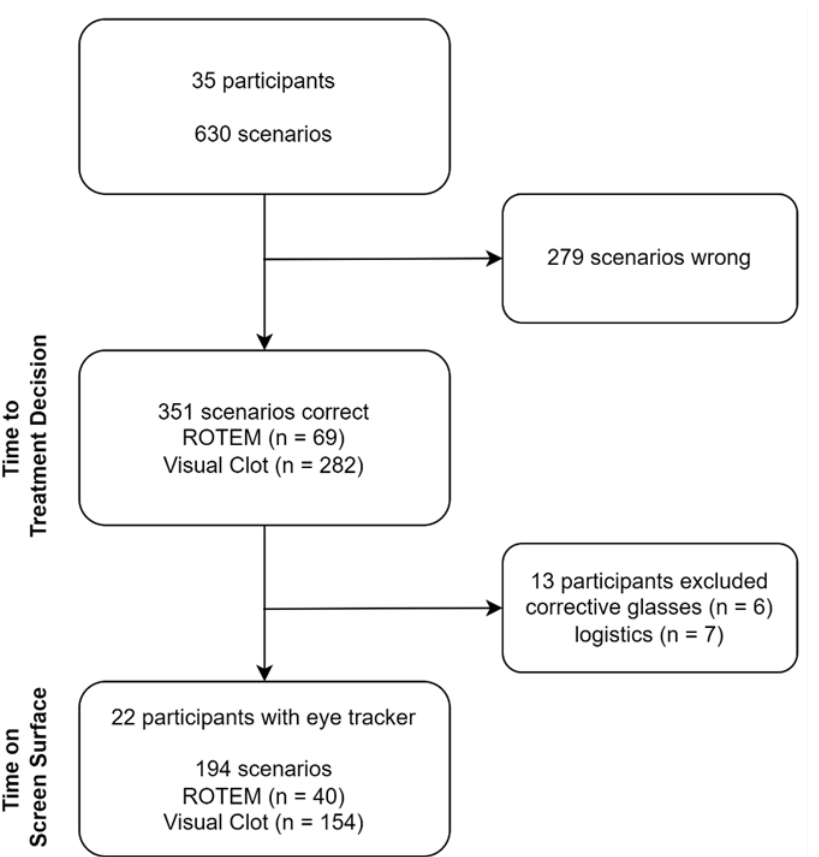
Figure 2. Flowchart presenting the total participant (n = 35) and scenario numbers (n = 630). Time to treatment decision is based on correctly answered scenarios (n = 351) of all participants. Time on screen surface is based on correctly answered scenarios (n = 194) of participants wearing the eye-tracking device (n = 22). ROTEM = rotational thromboelastometry. Table 1. Study and participant characteristics in detail. We present the data as numbers (%) or median (IQR) interquartile range (range). ROTEM = rotational thromboelastometry. Characteristic Number Participants, n (%) 35